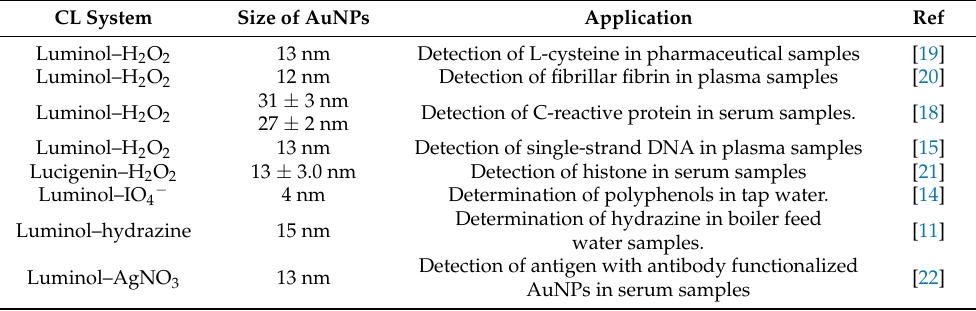
Table 1. Practical applications of gold nanoparticles (AuNPs) in different chemiluminescence (CL)